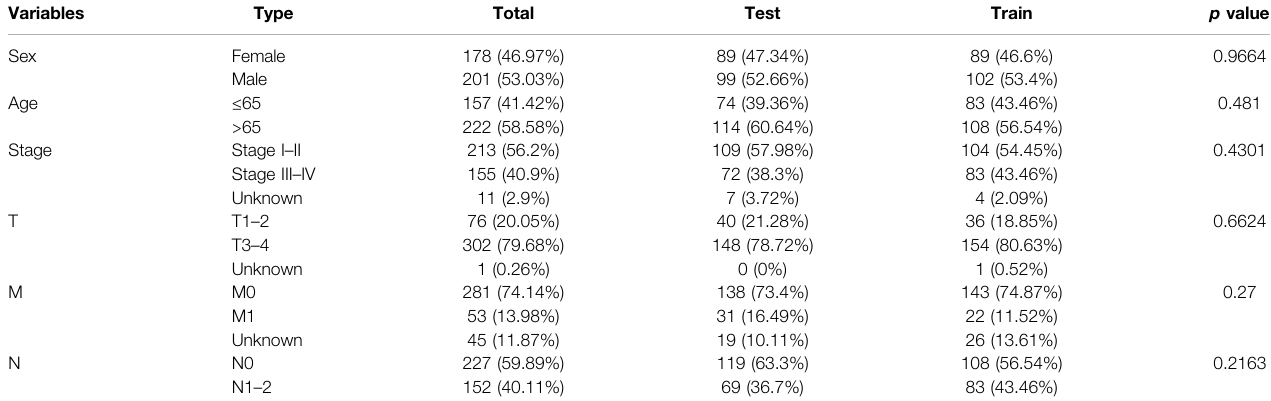
TABLE 1 | Age and sex characteristics and clinical information of COAD patients. Variables